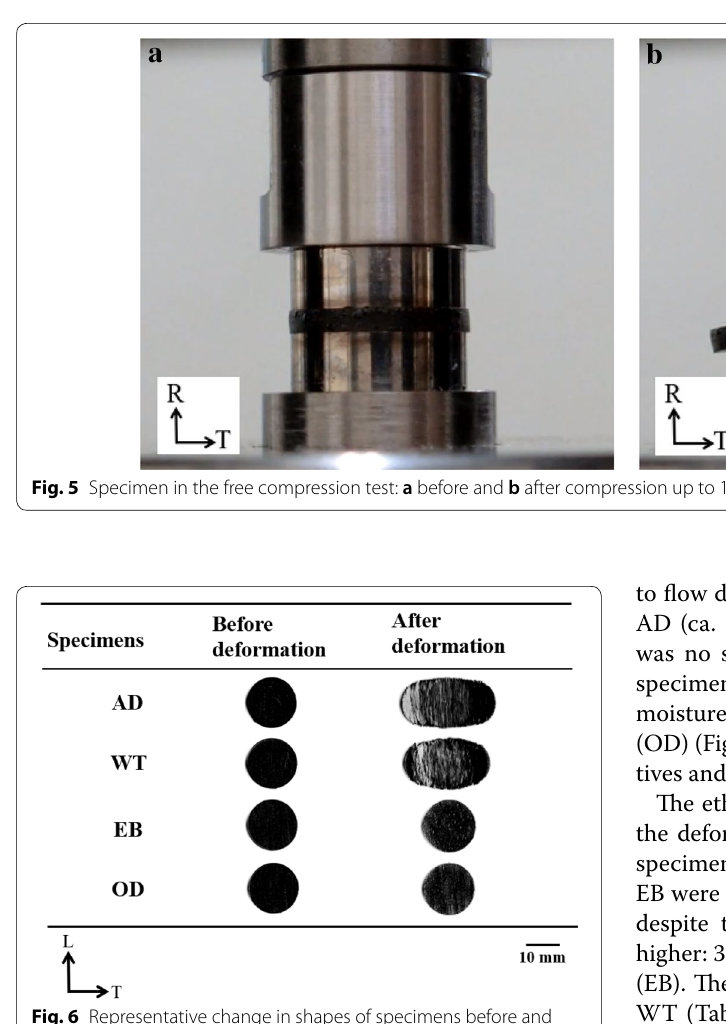
Table 1 Extraction rate, moisture content (MC) and dimensional changes due to free compression (mean